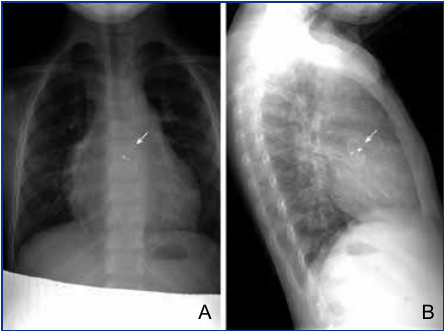
A Figure 2 Chest roentgenogram showed the ASO in an abnormal area. The white arrow points to the ASO.